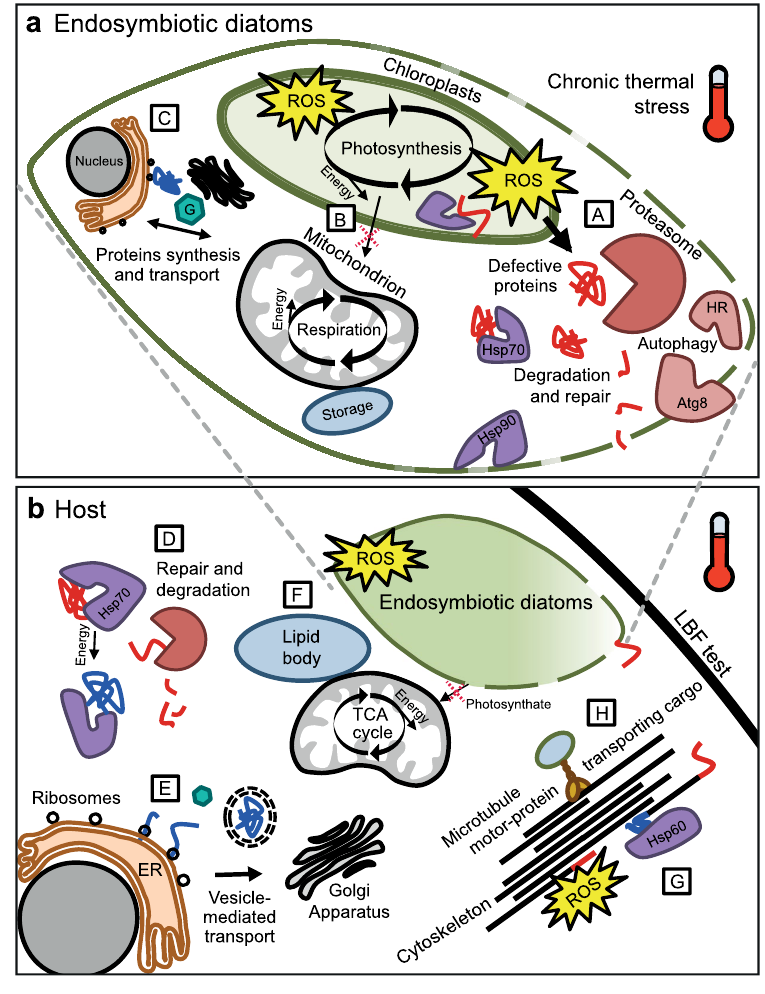
Figure 4. Chronic thermal stress induced the proposed cellular processes in the ( a ) photosymbionts and ( b ) the host cell of the large benthic foraminifera Amphistegina gibbosa . (A) Malfunctioning photosystems in the diatom chloroplasts produce reactive oxygen species (ROS), which damage cellular compounds. Molecular chaperones (purple) such as Hsp70 and Hsp90 stabilize and repair defective proteins (red) or target them for degradation by the proteasome. Cell death-related proteins (rose) such as hypersensitive response (HR) and autophagy-related protein 8 (Atg8) disassemble cellular components. (B) The damaged photosystems produce less cellular energy and photosynthate. To compensate for this and meet metabolic requirements, alternative resources e.g. stored in form of lipids are catabolized by the mitochondria. (C) Cellular constituents are partly reorganized through enhanced ion transport and cellular signalling ‘G’ proteins in combination with augmented biosynthesis of proteins (blue), possibly recycling the degraded compounds. In the host ( b ), the ROS lead to damaged or incorrectly folded proteins (D), but cellular homeostasis is maintained by chaperone- modulated repair mechanisms and targeted protein degradation. (E) Cell cycle-related functions of the endoplasmic reticulum (ER), ribosomes and the Golgi such as protein synthesis and modification combined with increase in proteins responsible for transport and signal conduction facilitates enhanced protein turnover. (F) Energy resources stored in lipid bodies are metabolized, e.g. through the tricarboxylic acid (TCA) cycle, to meet the augmented metabolic needs necessary for these stress response mechanisms, despite diminished supply of photosynthate by the impaired symbionts. (G) The cytoskeleton is damaged by the ROS-induced stress (red ends), but increased amounts of chaperonins such as Hsp60 assist in folding and stabilization of new cytoskeletal proteins. (H) Microtubule motor-proteins such as dynein increase to enhance intracellular transport, which could enable the host foraminifera to enhance heterotrophic feeding, transport of (damaged) proteins or symbionts to their required location, and the reallocation of energy